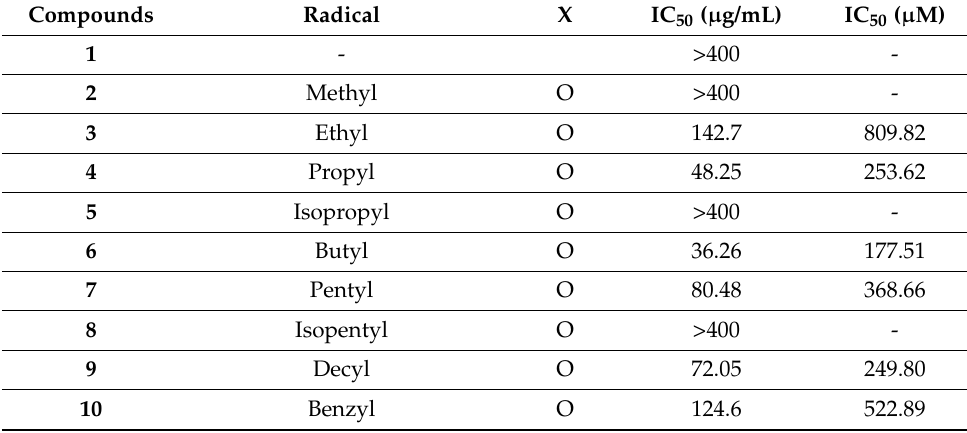
Table 1. Minimum Inhibitory Concentration (MIC) of compounds against Leishmania (Leishmania) infantum promastigotes. MIC values are expressed in µ g/mL and µ